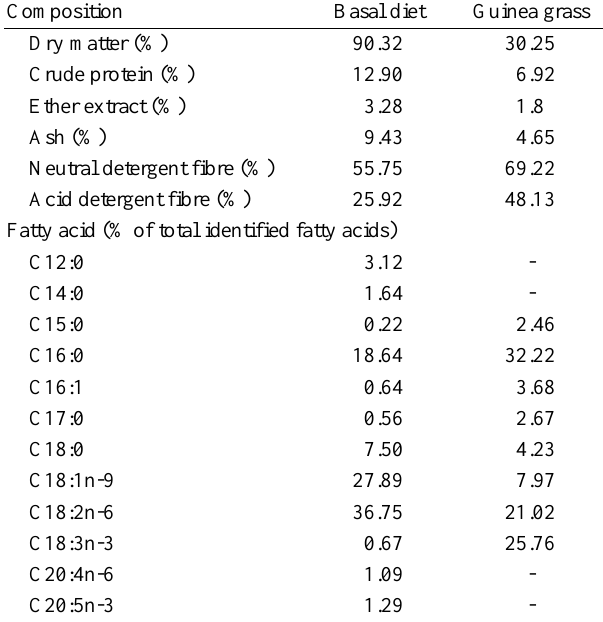
Table 1. Chemical composition and fatty acid profile of the basal diet and fresh guinea grass fed to goats in all treatments Composition Basal diet Guinea